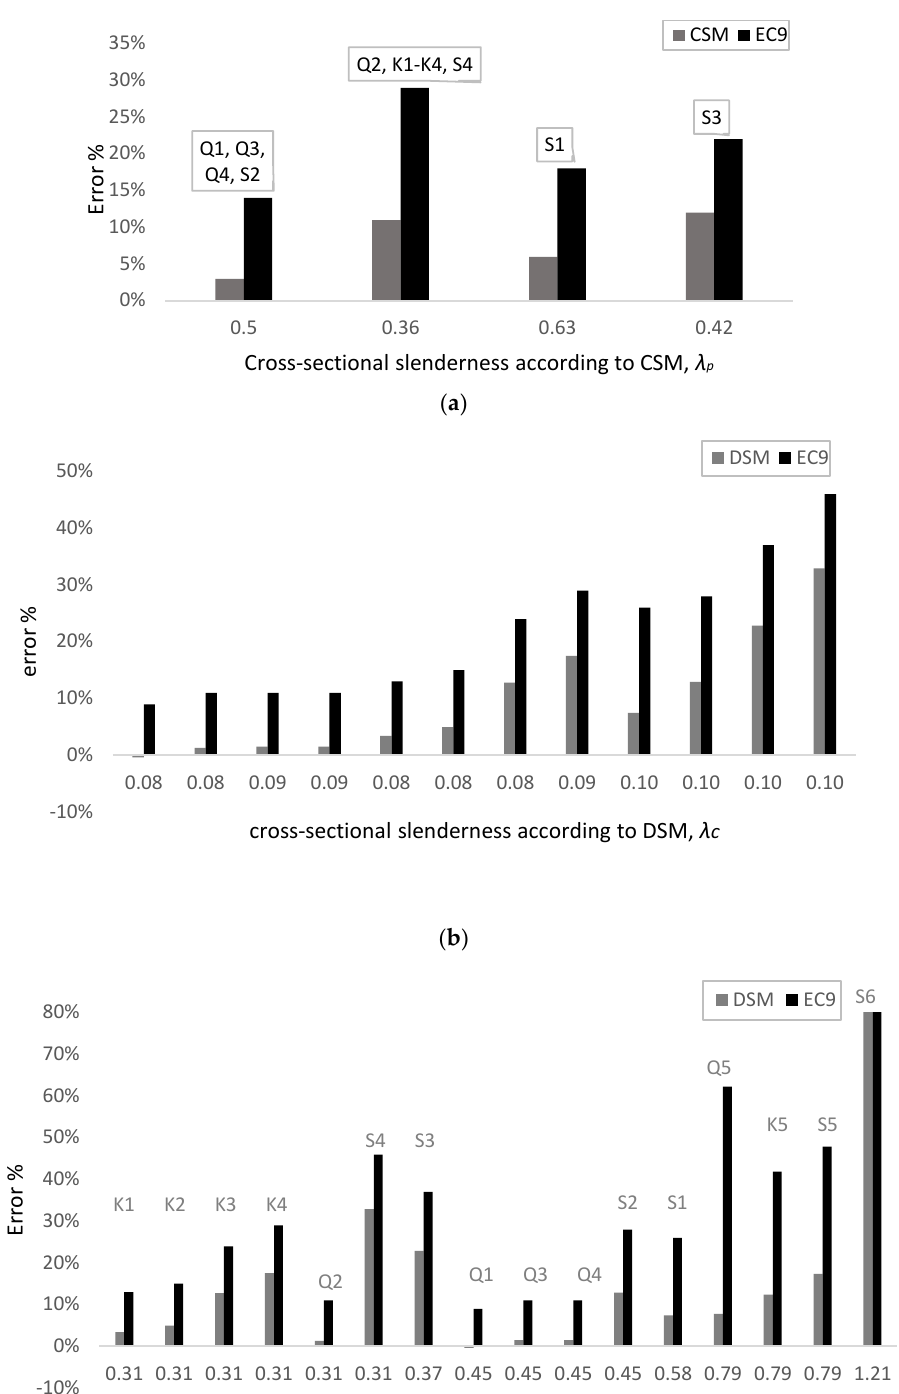
Figure A2. ( a ) Stocky cross-sections: error (percentage of difference among prediction value and FEA results). Predictions include EC9 and CSM. ( b ) Stocky cross-sections: error (percentage of difference among prediction value and FEA results). Predictions include EC9 and DSM. ( c ) All cross-sections: error (percentage of difference among prediction value and FEA results). Predictions include EC9 and